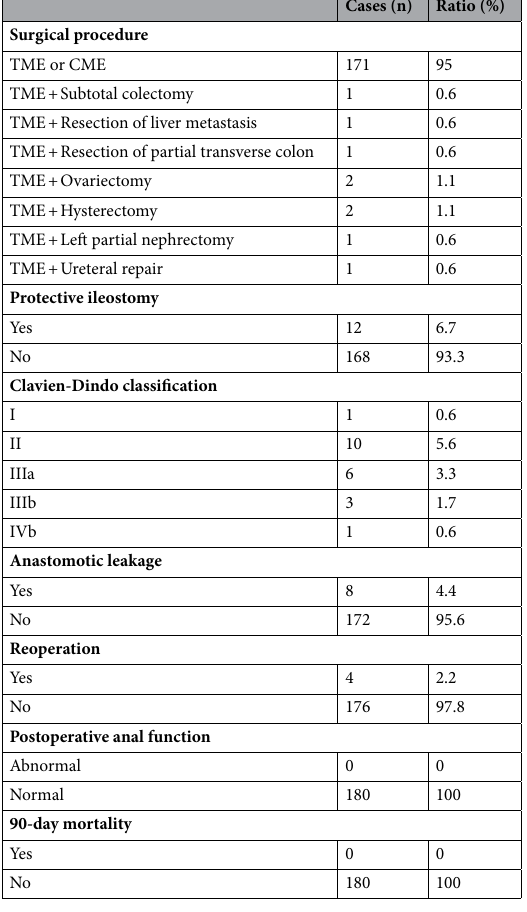
Table 3. Perioperative outcomes.